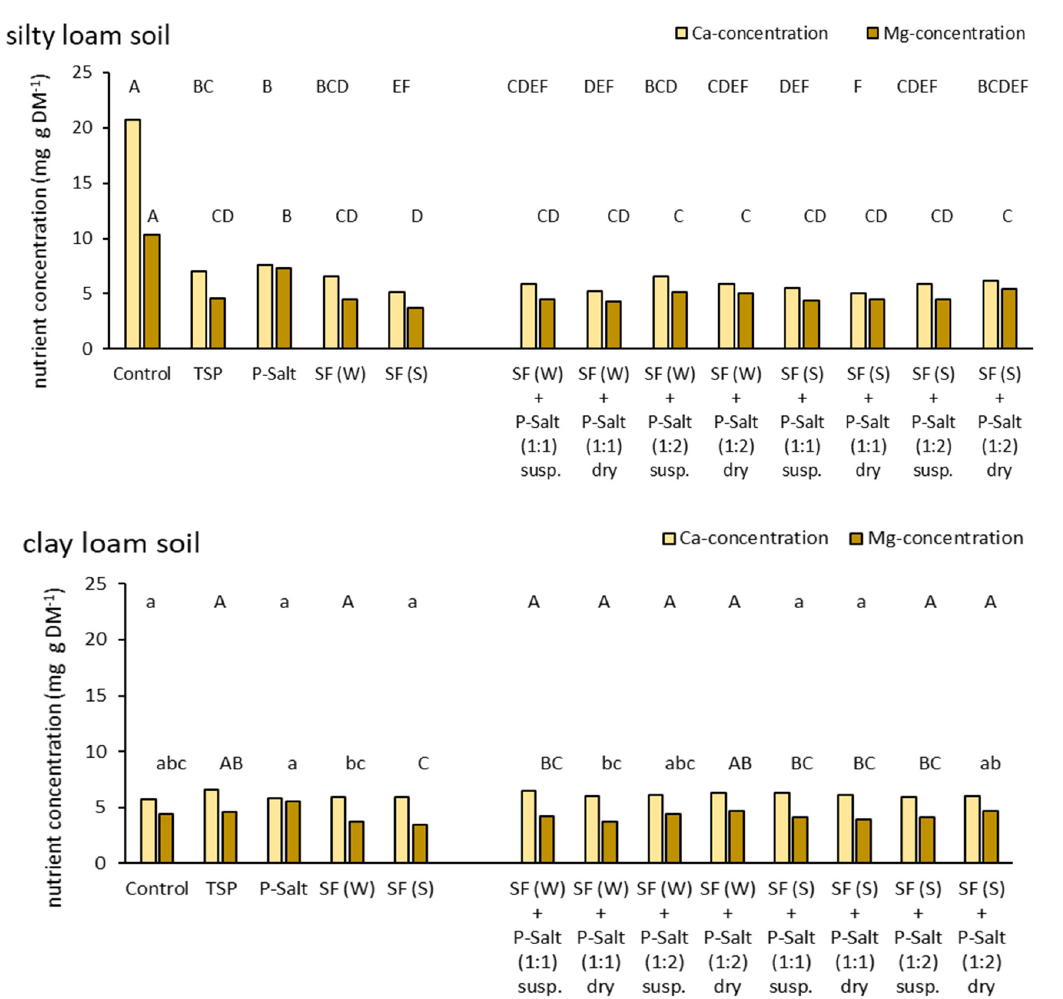
Figure 4. Maize P-, Ca- and Mg concentrations [mg g DM − 1 ] after soil treatment with different recycled digestate fertilizers in a total dose equivalent to 150 mg P (kg soil − 1 ). Please see Figure 3 for all other details. Data are means of four replicates each. Different letters denote significant differences (two-factorial Tukey’s test with p ≤ 0.05). Lowercase and uppercase letters indicate significantly different mean values between both soil types. Uppercase letters for both soil types indicate no significant difference.